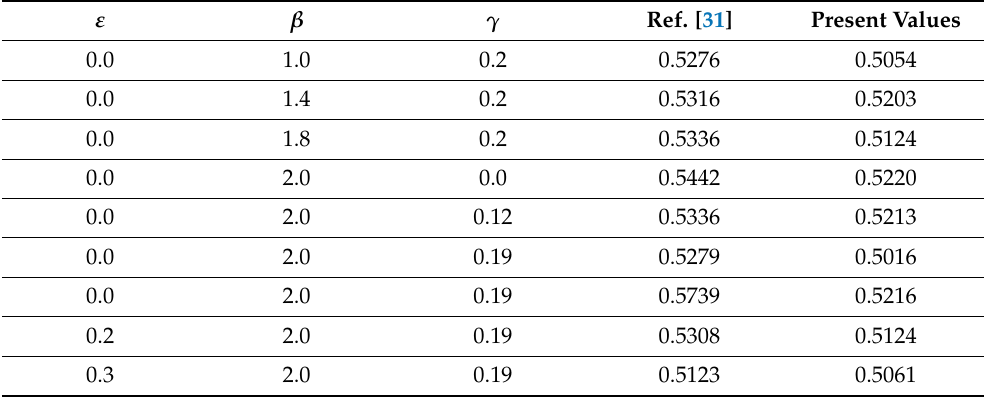
Table 17. Comparison of Nusselt number with Ref.